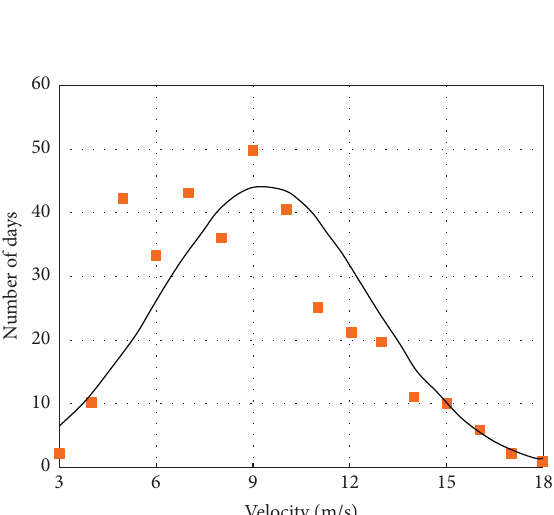
Figure 6: The frequency distribution of temperature in the period of one year.